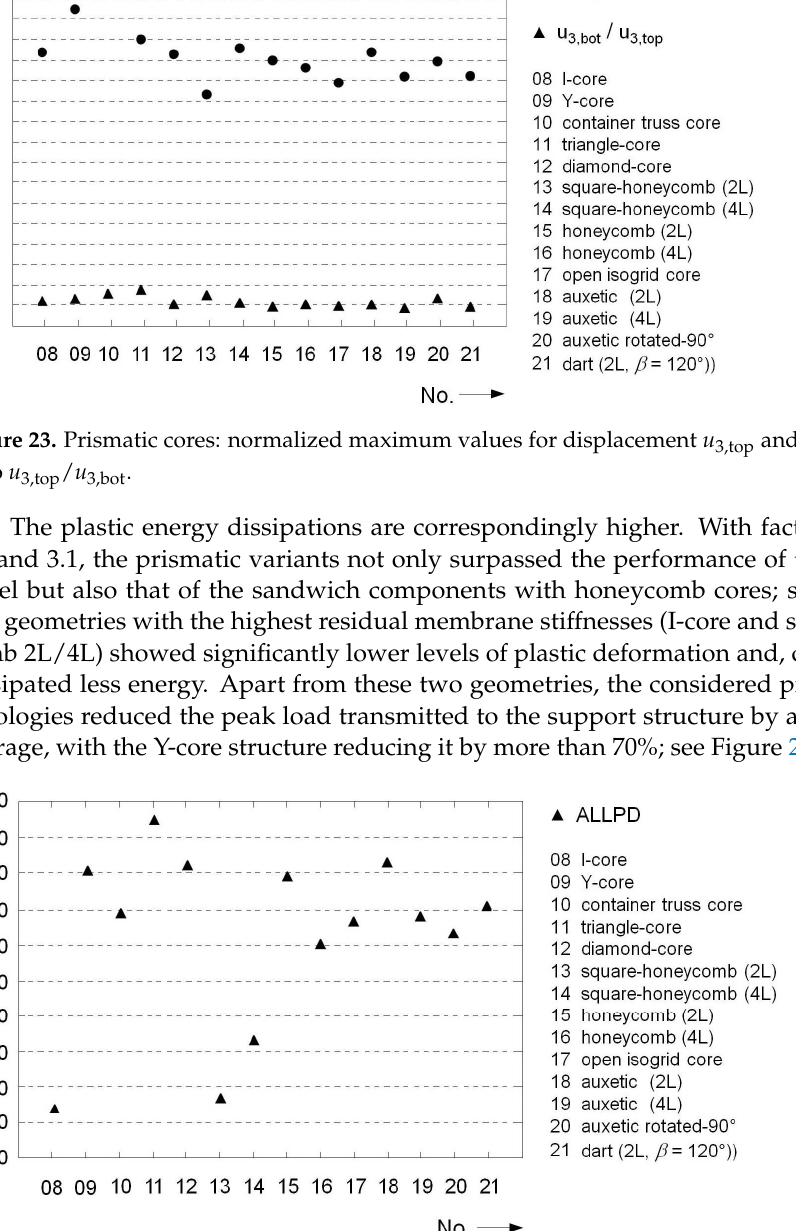
Figure 22. Prismatic cores: normalized maximum values for displacement 𝑢 (cid:2871),(cid:2912)(cid:2925)(cid:2930) and reaction force RF 3 .